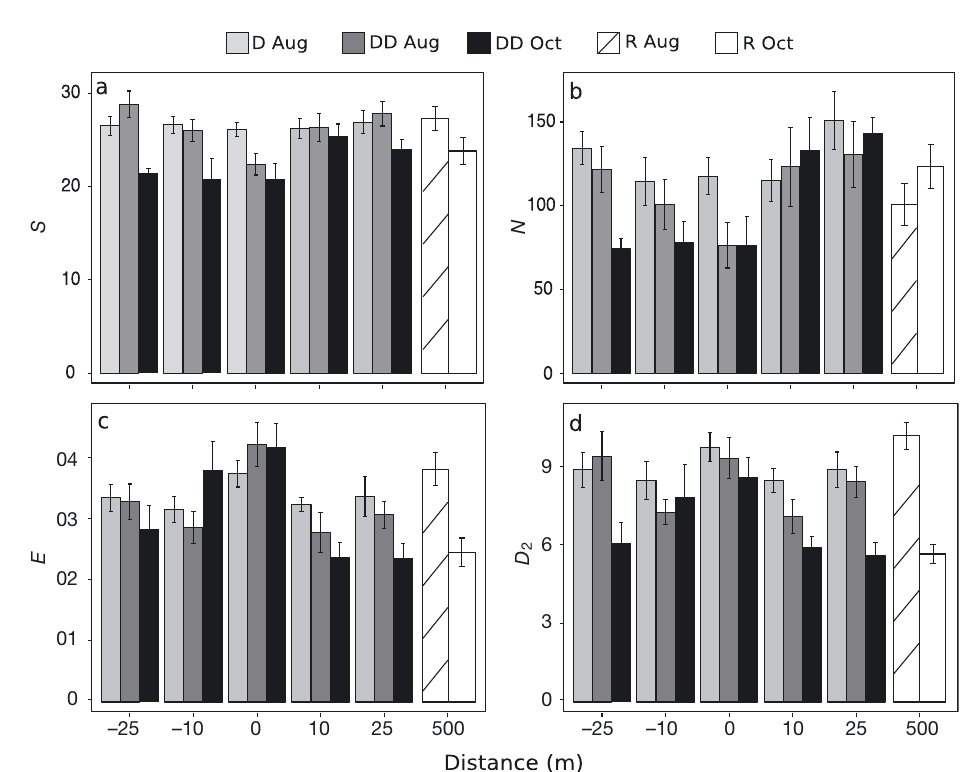
Fig. 5. Mean (±SE) (a) number of taxa ( S) , (b) abundance ( N in ind. 78.5 cm −2 ), (c) evenness ( E) and (d) Simpson’s inverse index ( D 2 ) recorded along transects under standard (D) and double density (DD) longlines and at reference stations (R), in August and October 2013 (only DD and R in